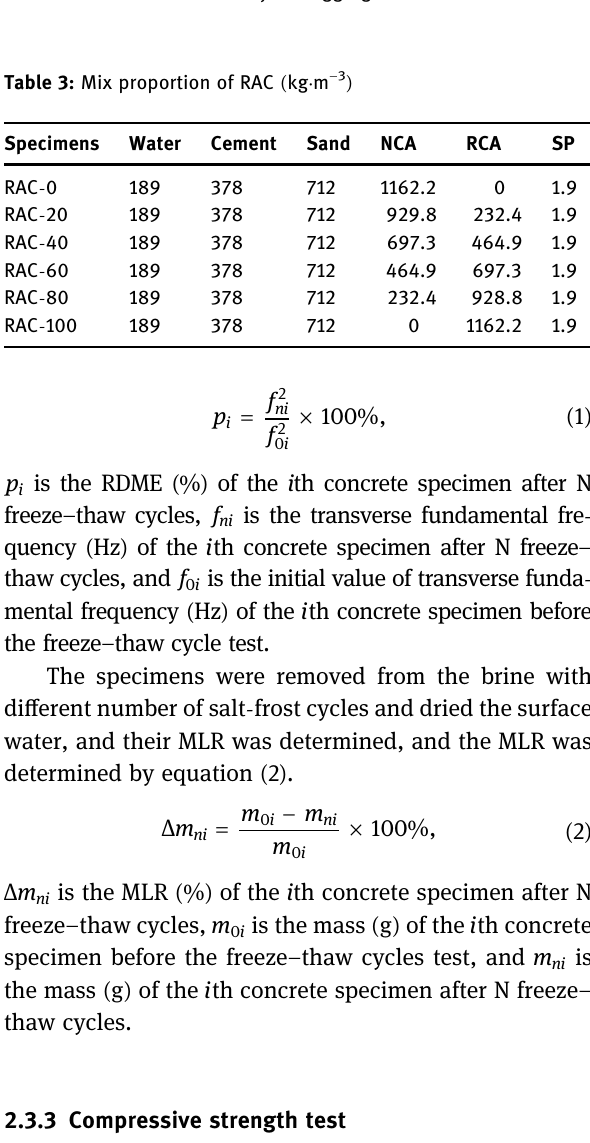
Table 2: Physical properties of aggregates